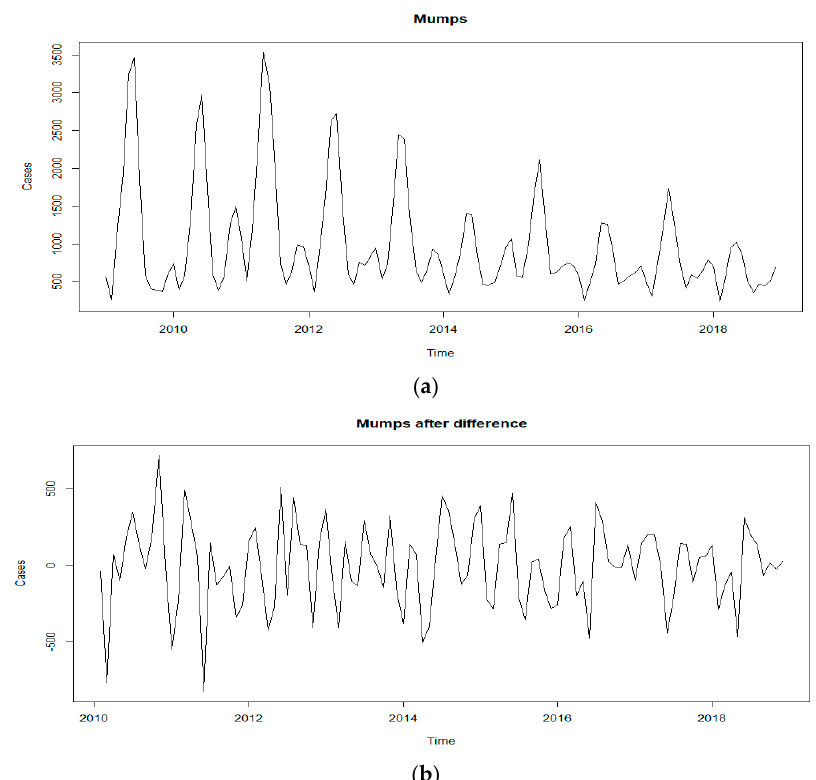
Figure 2. Sequence diagram of mumps: ( a ) Reported monthly mumps cases from January 2009 to December 2019; ( b ) monthly mumps cases after difference.